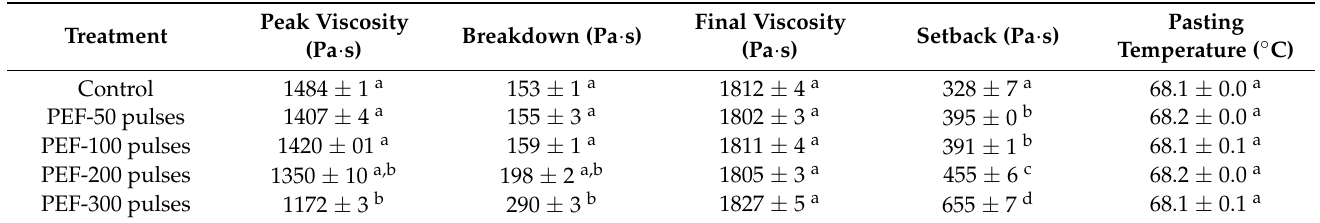
Table 3. Viscosity parameters of glutinous rice flour with or without PEF treatment measured in the rheological test of time and temperature